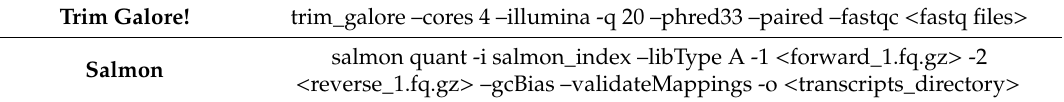
Table A1. Specific arguments used during the analysis. Unless explicitly specified otherwise, default parameters were